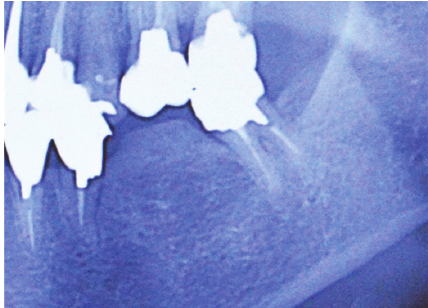
Figure 5: Intraoral photographic image after detachment of the sequestrum. Epithelialization was underway with no exposed bone.